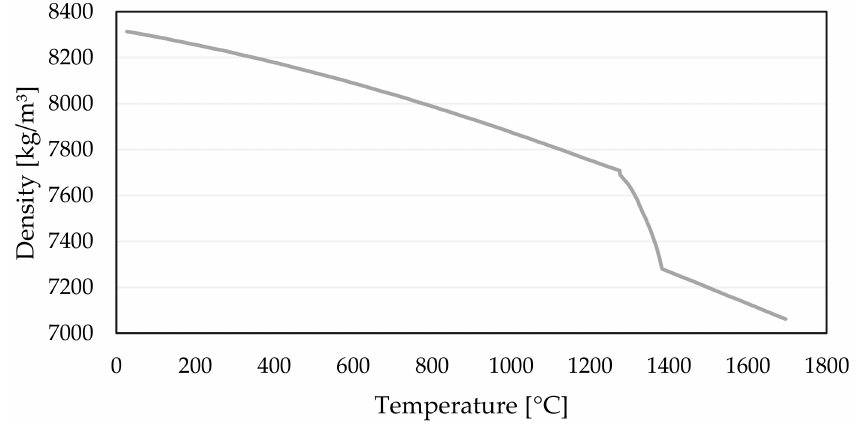
Figure 3. Density as a function of temperature [17].